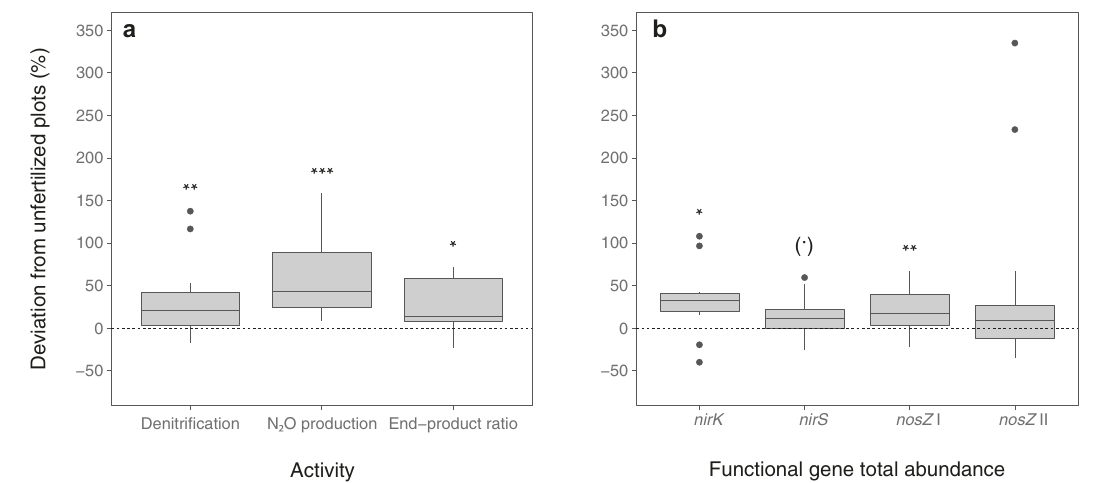
Fig. 1 Percentage change in mean functional and genetic potentials for denitri fi cation and N2O reduction in soils under long-term N fertilization compared to unfertilized soils across 14 different long-term experiments. a Percent change in potential denitri fi cation activity, potential net N 2 O emissions and the ratio of denitri fi cation end products in fertilized plots compared to unfertilized control plots. b Percent change in functional gene relative abundances (copies per 16S rRNA gene copies) in fertilized plots compared to unfertilized control plots. Asterisks indicate signi fi cance of deviation from zero (Wilcoxon signed-rank test [ N = 14], (.) p < 0.1, * p < 0.05, ** p < 0.01, *** p < 0.001). Box limits represent the inter-quartile range (IQR) with median values represented by the centreline. Whiskers represent values ≤ 1.5 times the upper and lower quartiles, while points indicate values outside this